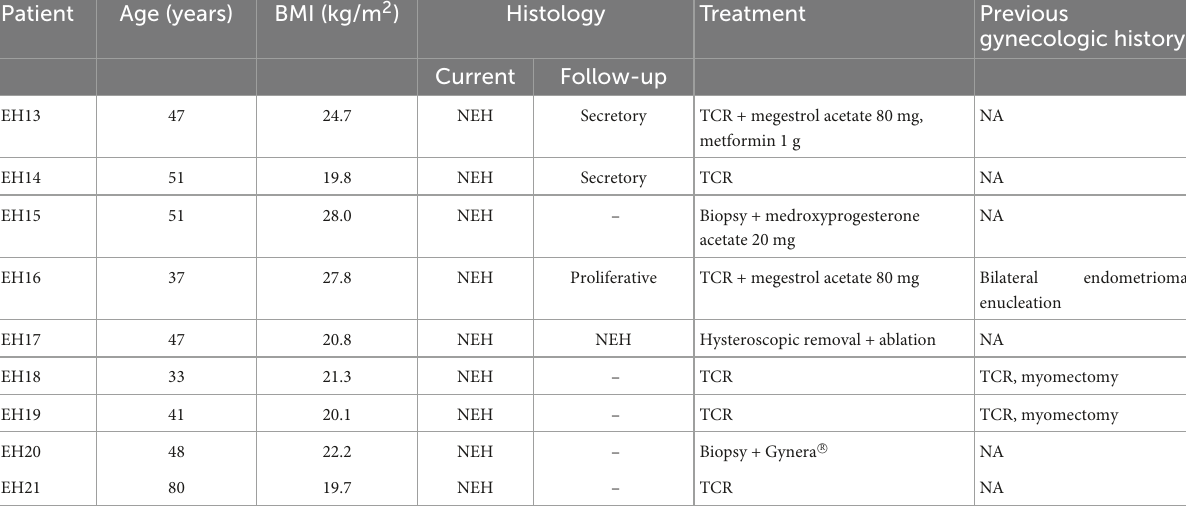
TABLE 2 Clinicopathologic characteristics of women with non-atypical endometrial hyperplasia. Patient